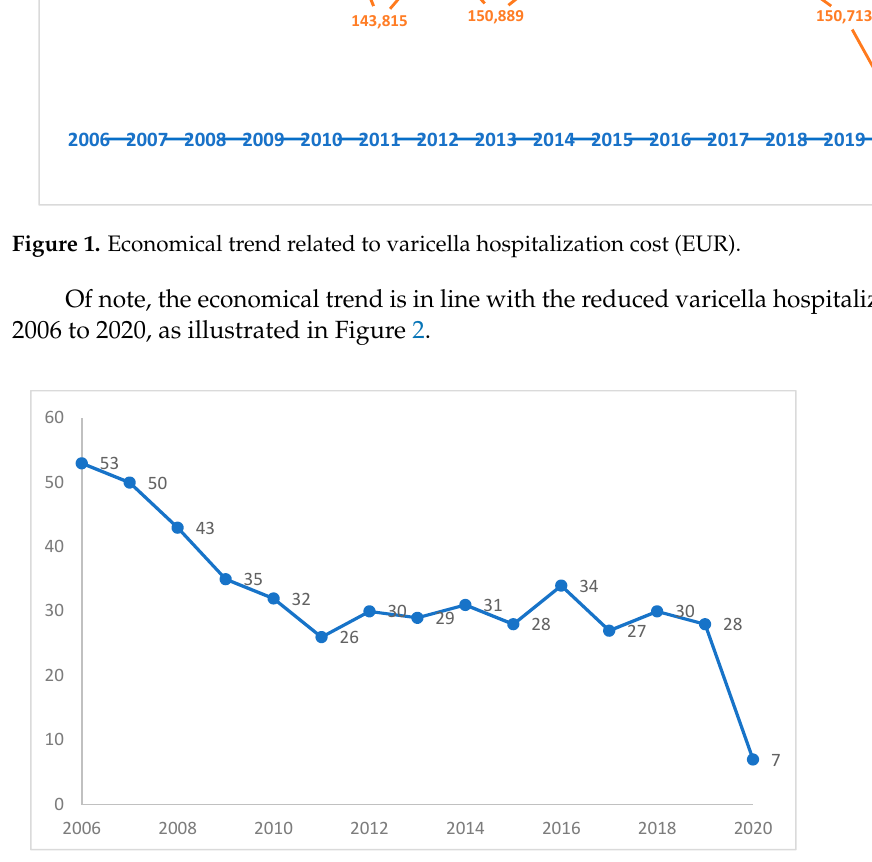
Figure 2. Varicella hospitalization trend from 2006 to